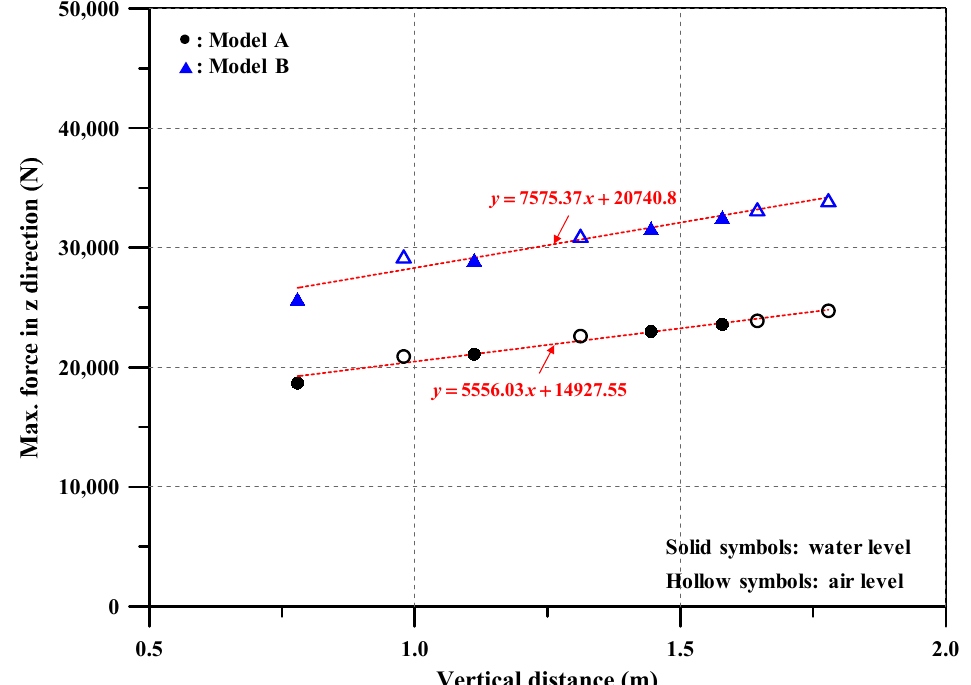
Figure 16. Numerical results according to vertical distance.